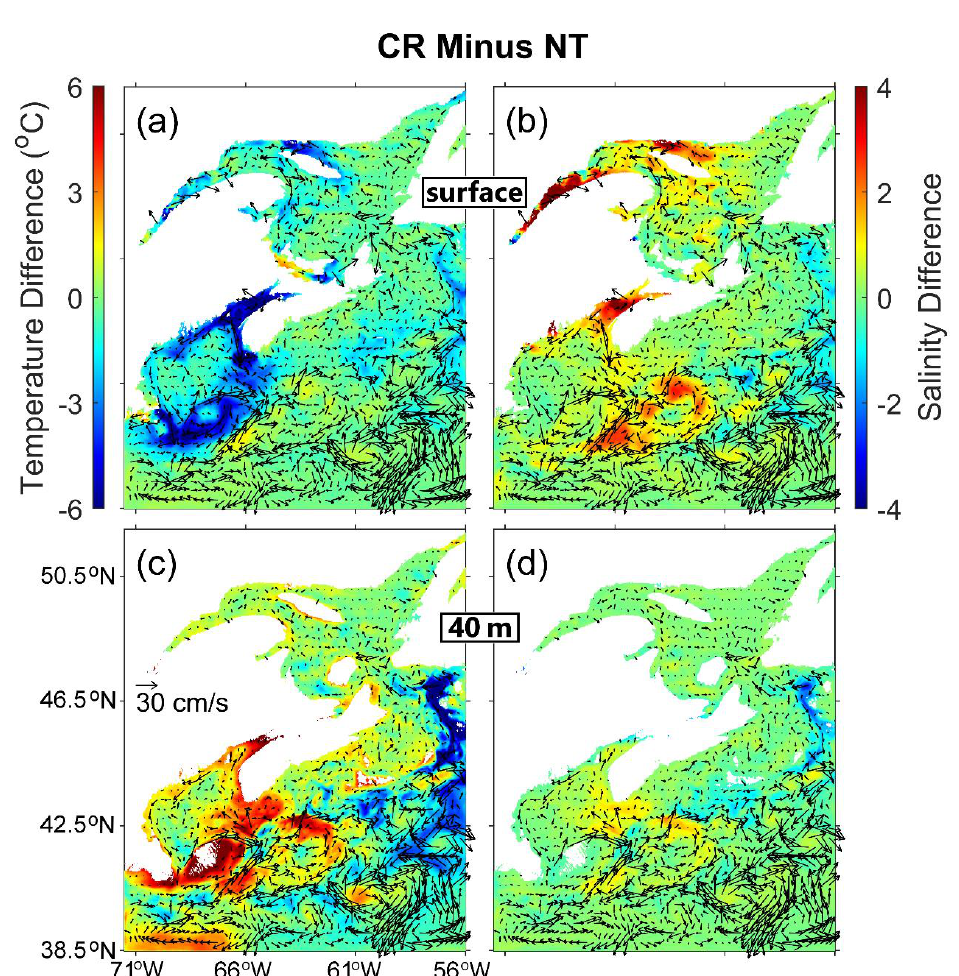
Figure 16. Differences in monthly-mean currents (black and red arrows), temperature ( a , b ), and salinity ( c , d ) simulated by submodel L2 for August 2018 between cases CR and NT at ( a , b ) the surface and ( c , d ) 40 m. For clarity, velocity vectors are plotted at every 11th model grid point. Different scales are used for the black and red arrows.